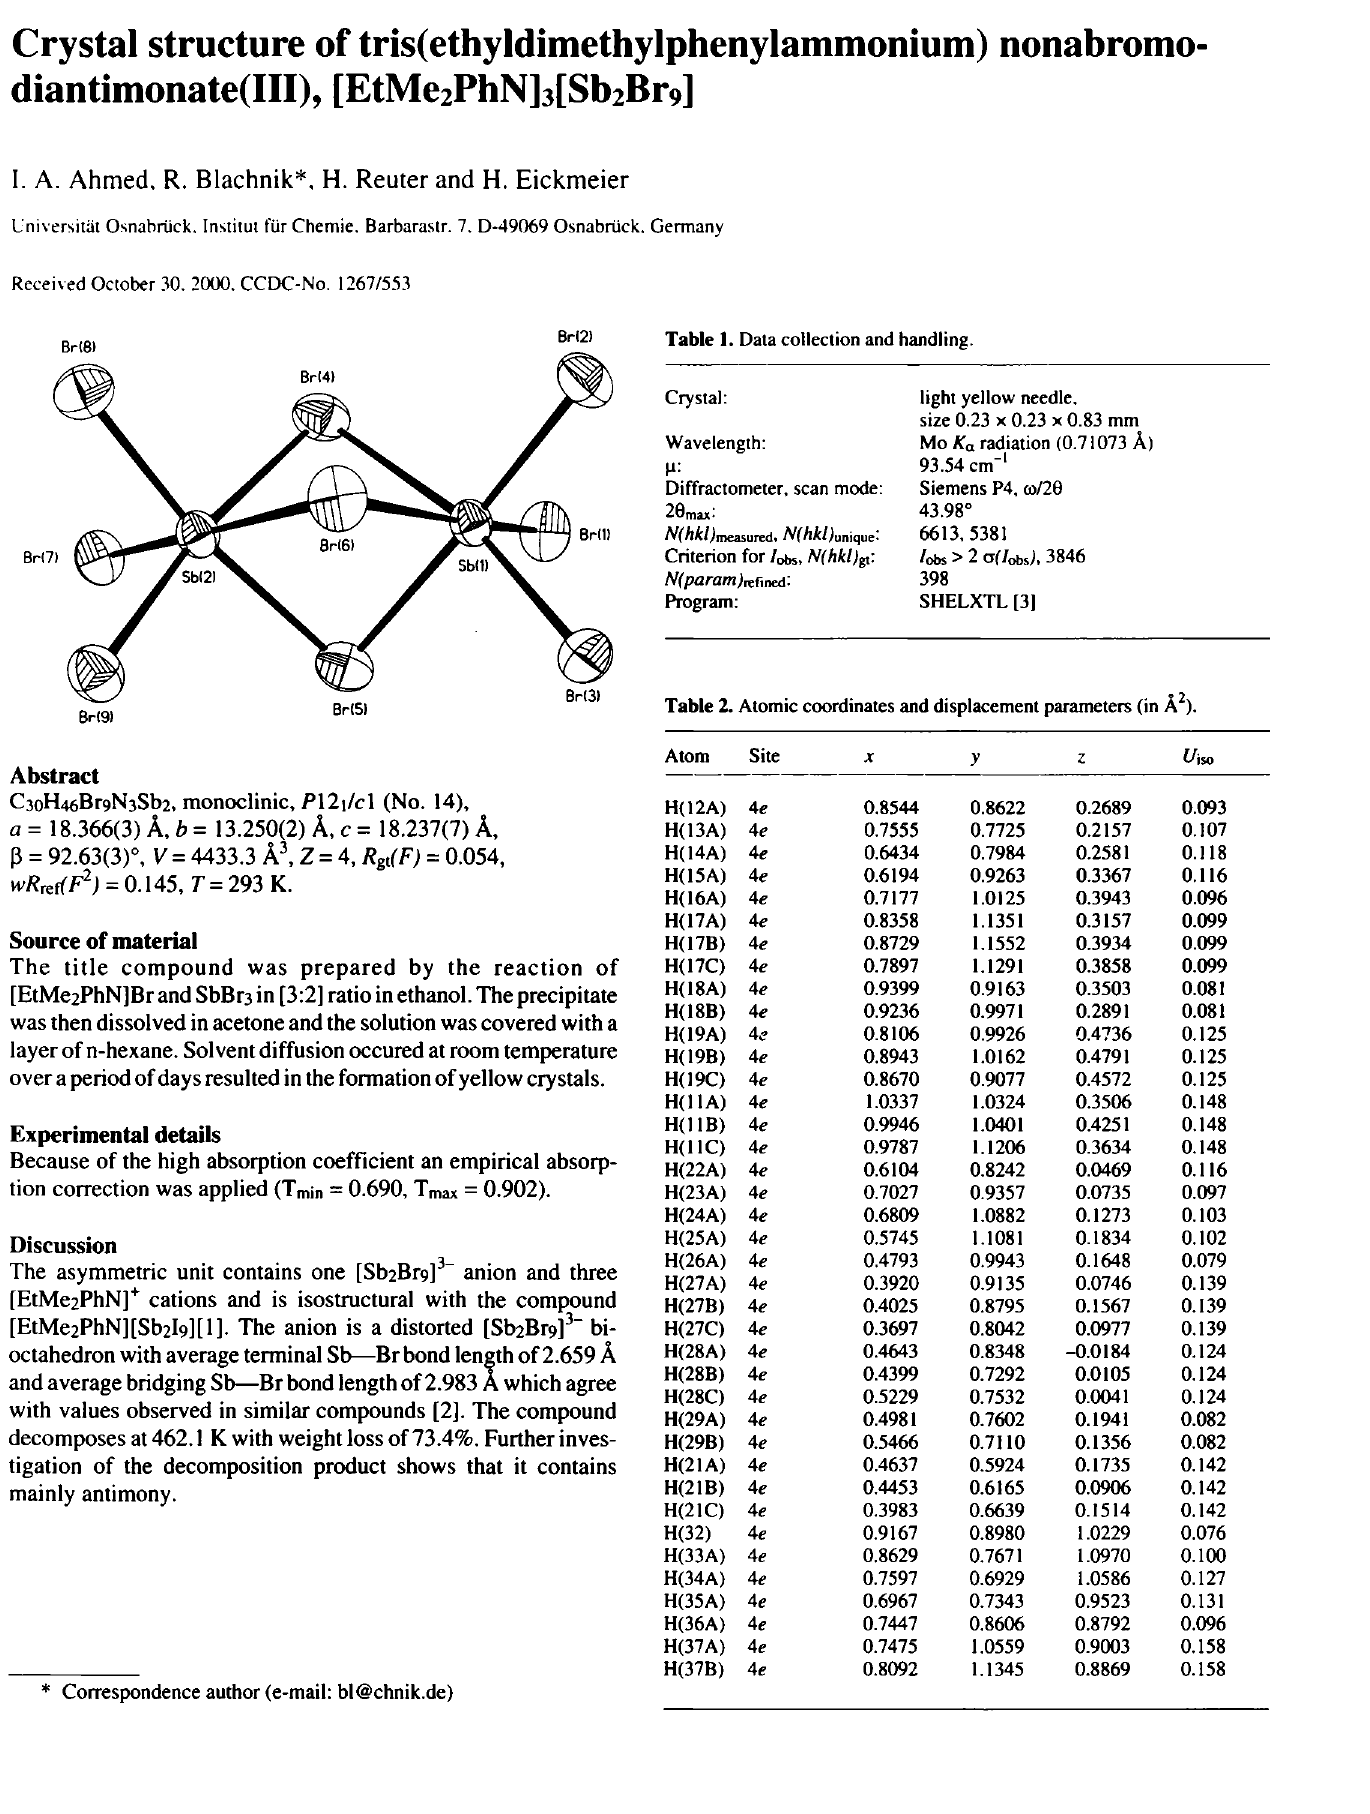
Table 2. Atomic coordinates and displacement parameters (in Ä 2